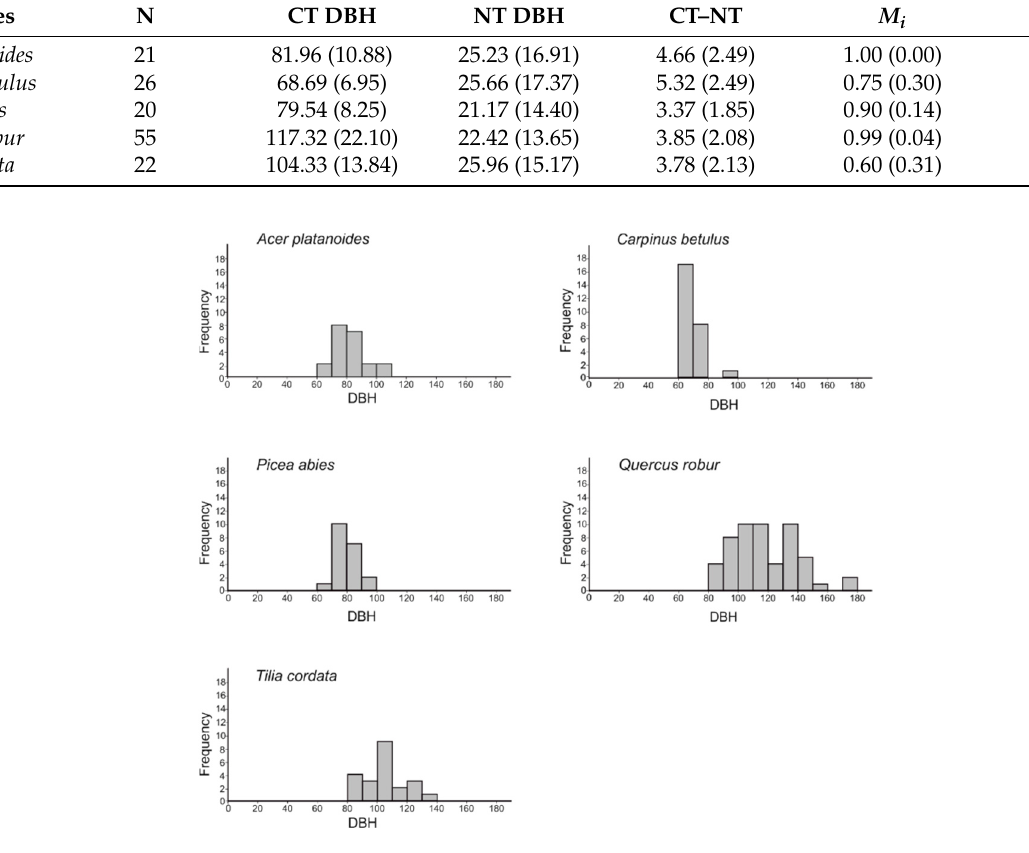
Figure A1. Distribution of the central tree diameter at breast height by species: Acer platanoides , Carpinus betulus , Picea abies , Quercus robur and Tilia cordata